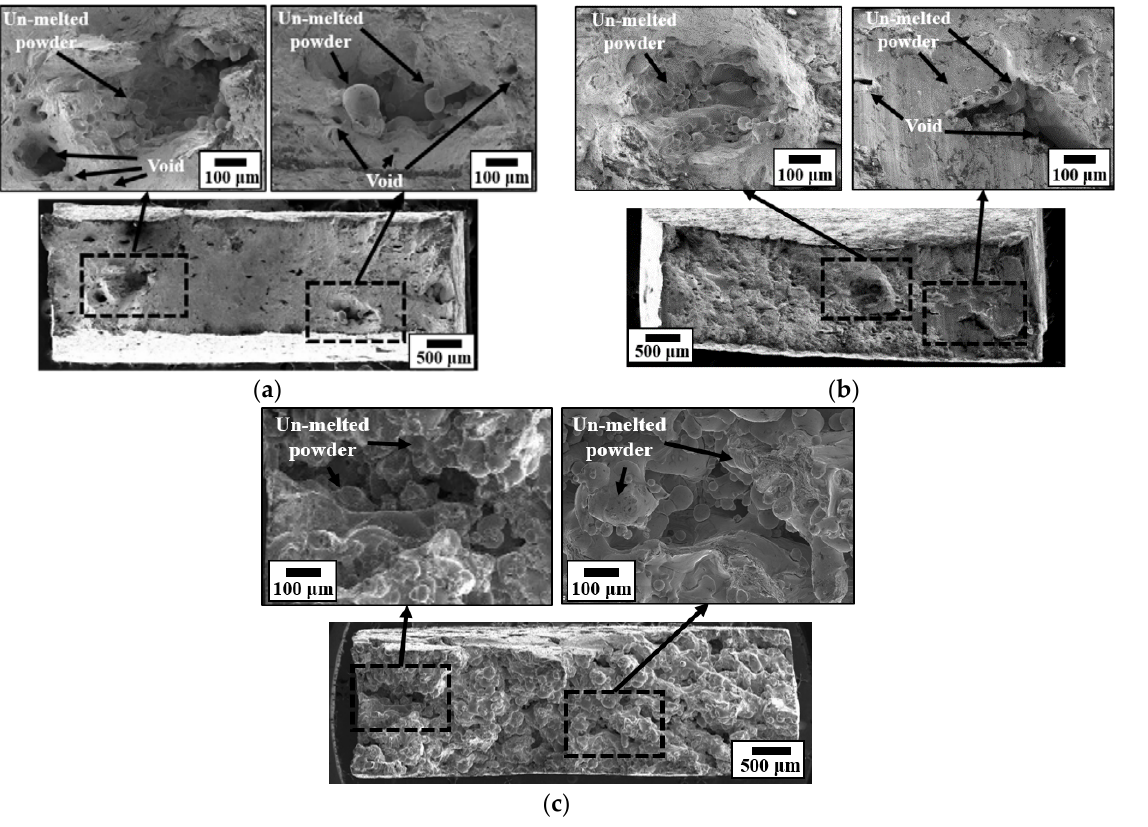
Figure 11. Images of the fracture surface for different energy densities (J/mm 3 ): ( a ) energy density 155 J/ mm 3 ; ( b ) energy density 118 J/mm 3 ; and ( c ) energy density 68 J/mm 3 .